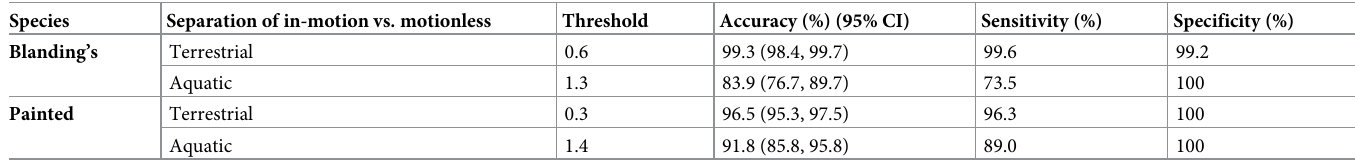
Table 1. Overall classification performance for the testing data used to classify Blanding’s turtle and Painted turtle activity based on only accelerometry data, sam- pled at 1 Hz. Species Separation of in-motion vs. motionless